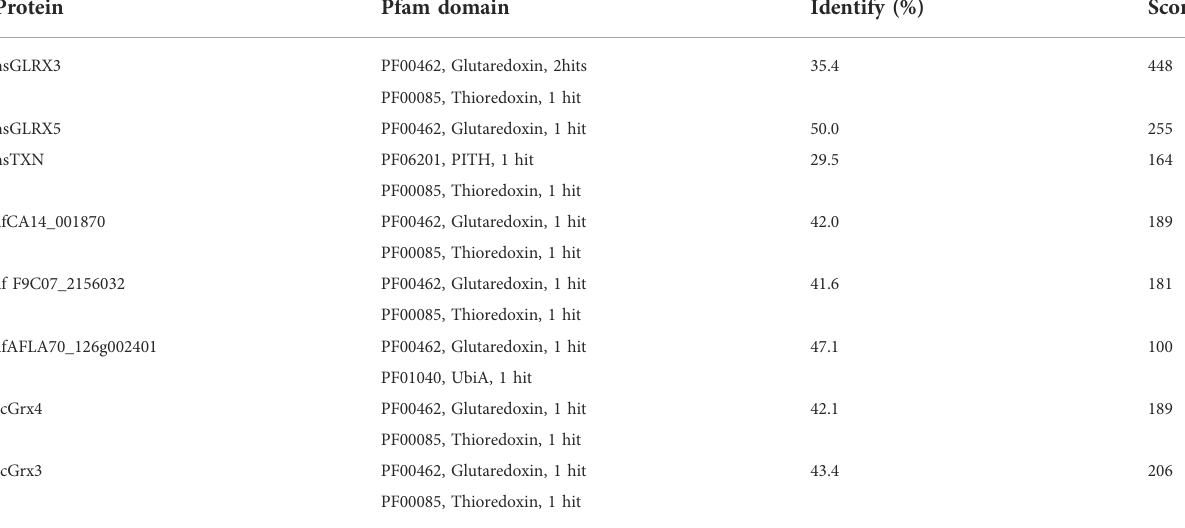
TABLE 1 Sequence comparison of spGrx4 to its sequence homologs in A. fl avus , H. sapiens , and S. cerevisiae .